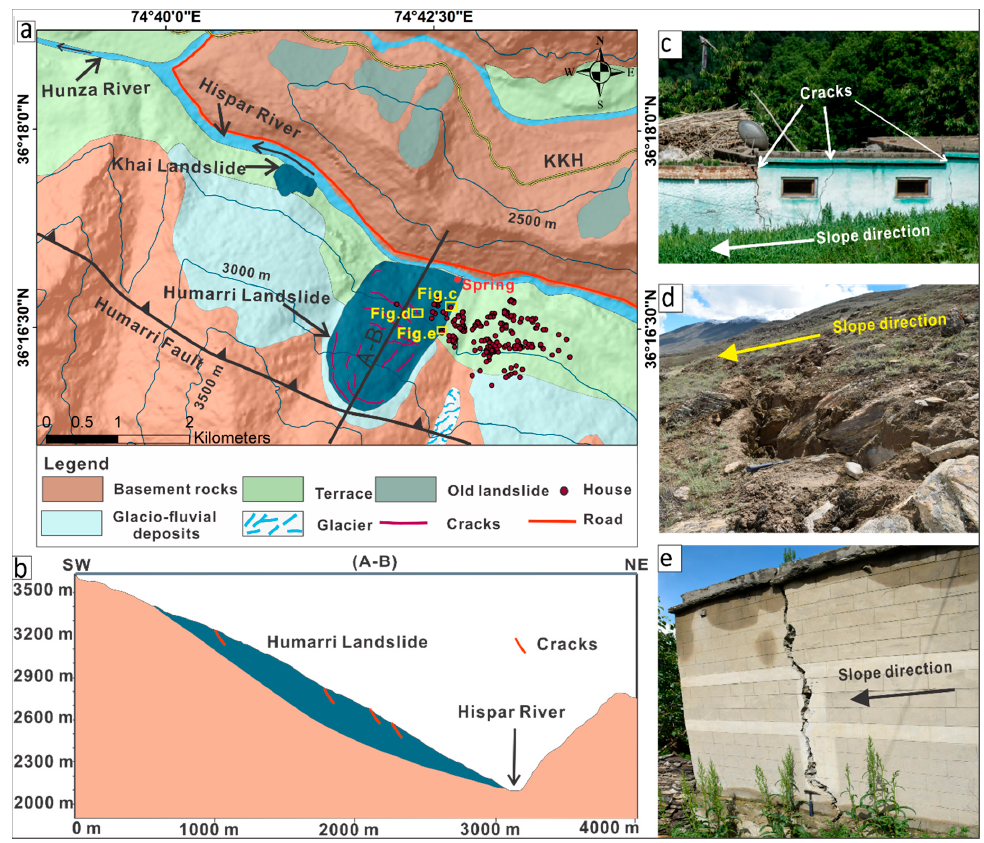
Figure 11. ( a ) Geomorphic map of Humarri landslide region. ( b ) Cross-section along line A-B as shown in ( c , e ) with cracks in houses recognized during the field survey in the Humarri village. ( d ) Example of tension cracks in the landslide.